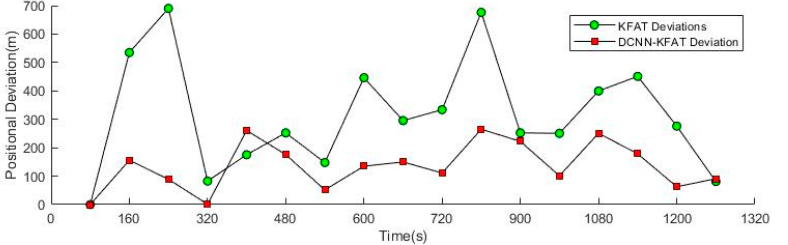
Figure 23. Comparison of the deviation of tracking results for target 1 between the two methods. The DCNN-KFAT method is more accurate than the KFAT method.